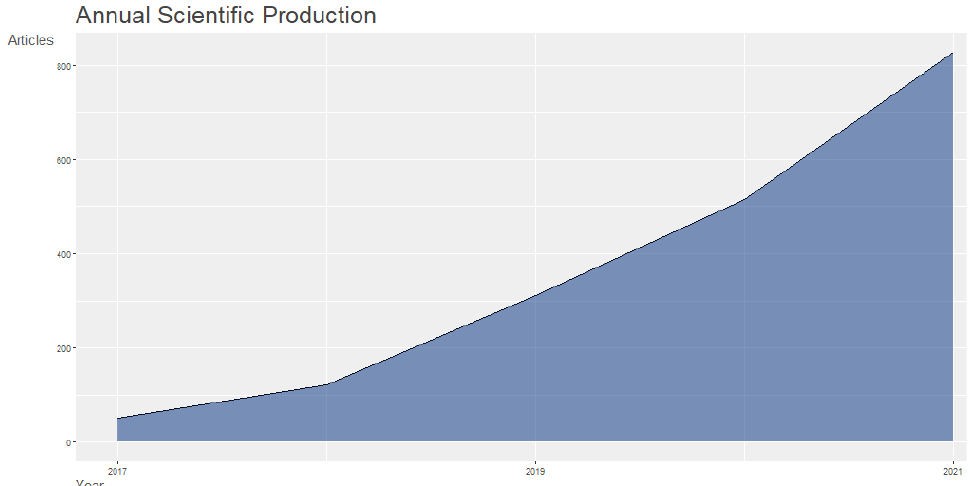
Figure 4. Annual scientific production of publications in smart farming. Source: Scopus-Bibliosh- iny.